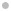
Fosmidomycin antibacterial activity in GlpT deficient E. coli.GlpT transporter-containing (■ BW25113) and deficient (● ΔglpT BW25113) E. coli strains treated with 2800 μM (512 μg/mL) fosmidomycin in CAMHB (a), M9-glucose (b), and M9-glycerol (c) growth medium. Cell growth was assessed at 16 h (CAMHB, M9-glucose) or 40 h (M9-glycerol) to ensure culture saturation. The large MIC shift between the parent and GlpT deficient strain in CAMHB and M9-glycerol media indicate that GlpT is a fosmidomycin transporter in these growth conditions. (n = 3, error bars represent standard error).